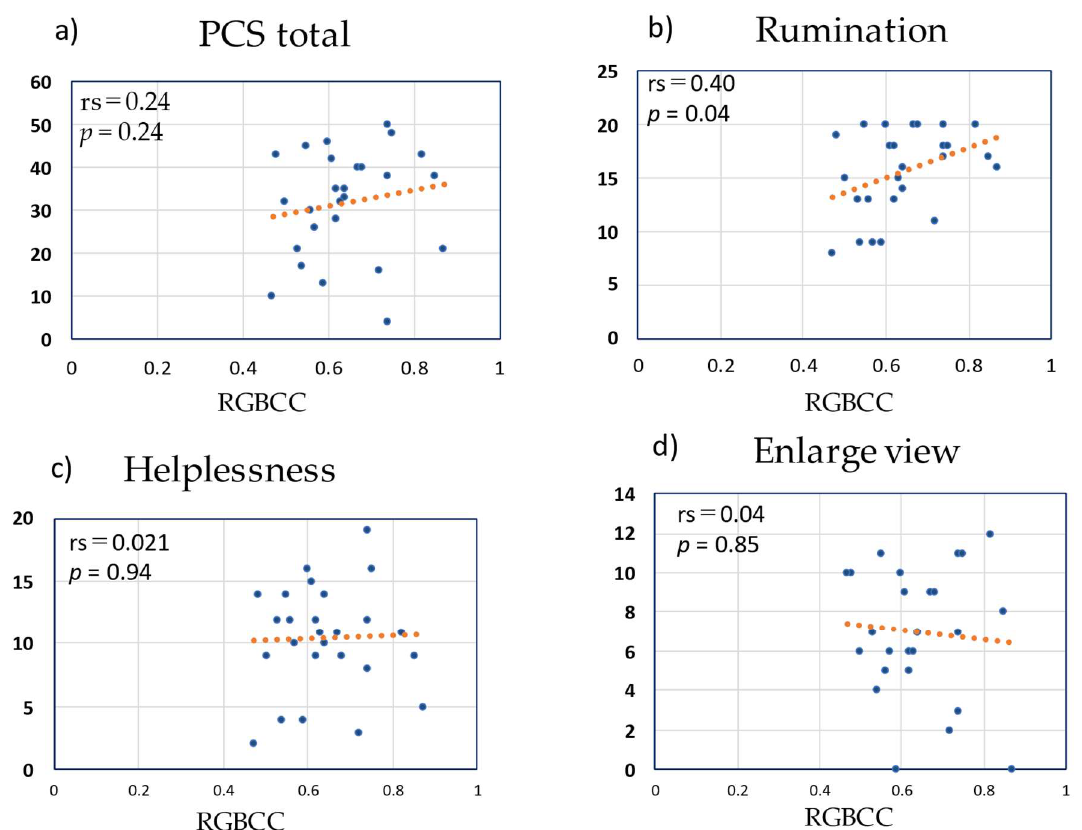
Figure 8. Correlations of red, green, and blue correlation coefficient (RGBCC) with Pain Catastrophizing Scale (PCS) scores. ( a ) RGBCC versus total PCS score, ( b ) RGBCC versus rumination score, ( c ) RGBCC versus helplessness score, ( d ) RGBCC versus magnification score.